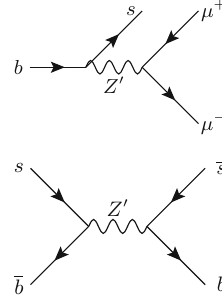
θ is the complex scalar flavon field, whose vacuum expecta- tion value (cid:5) θ (cid:6) is assumed to be around the TeV scale, break-